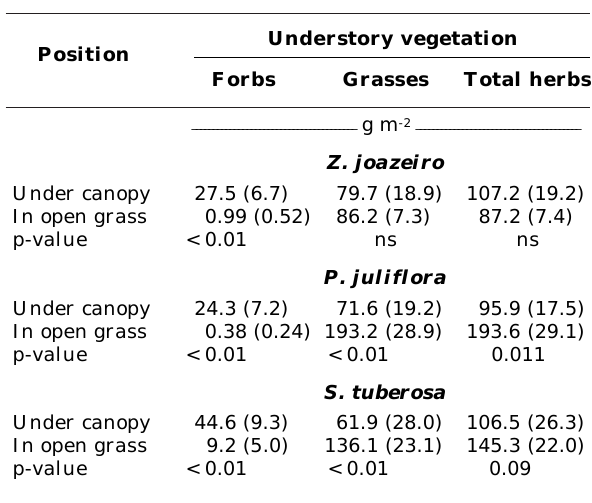
Table 2. Mean values and standard errors (n = 21) of dry matter under and outside (open grass) the canopy of Z. joazeiro , P. juliflora and